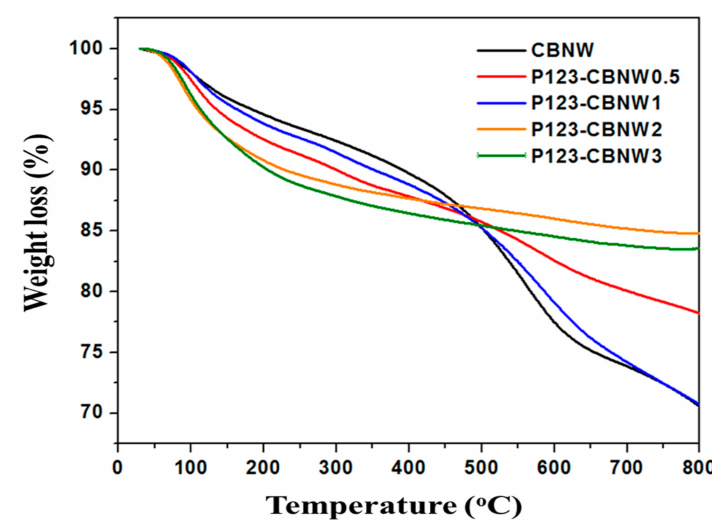
Figure 3. TGA curves of prepared samples in an air atmosphere (10 ◦ C / min).